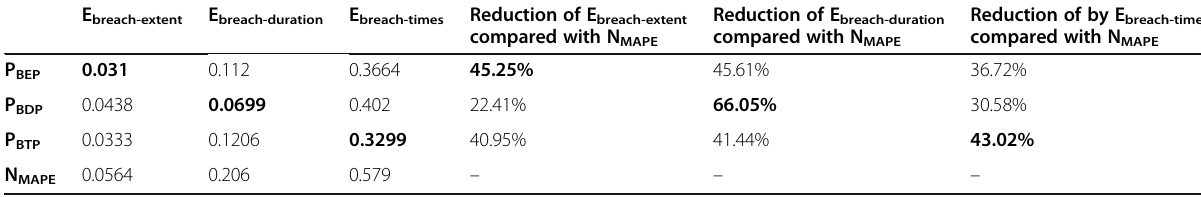
Table 10 Intent breach risk evalution of n-mode and p-mode models E